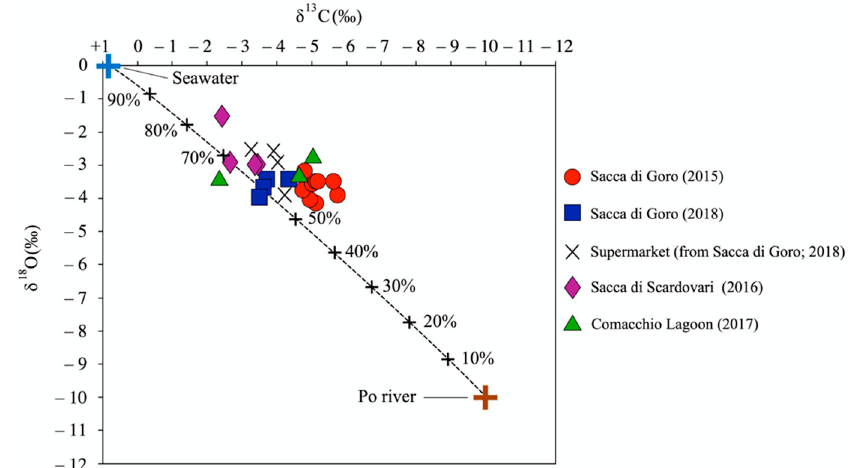
Figure 5. The δ 13 C and δ 18 O isotopic ratios of shells of manila clams collected on-site from northern Adriatic lagoons and bought at a local supermarket. The isotopic ratios of C of dissolved inorganic carbon (DIC) for seawater and the Po River are from Hoffman and Lamothe [64] and Marchina et al. [15], respectively, whereas the isotopic O of seawater is the typical value for Standard Mean Ocean Water (SMOW), and that of the Po River is from Marchina et al. [15]. Tick marks on the sea- water–riverine mixing line indicate the contribution of seawater. The analytical uncertainties are negligible at the graphical scale.